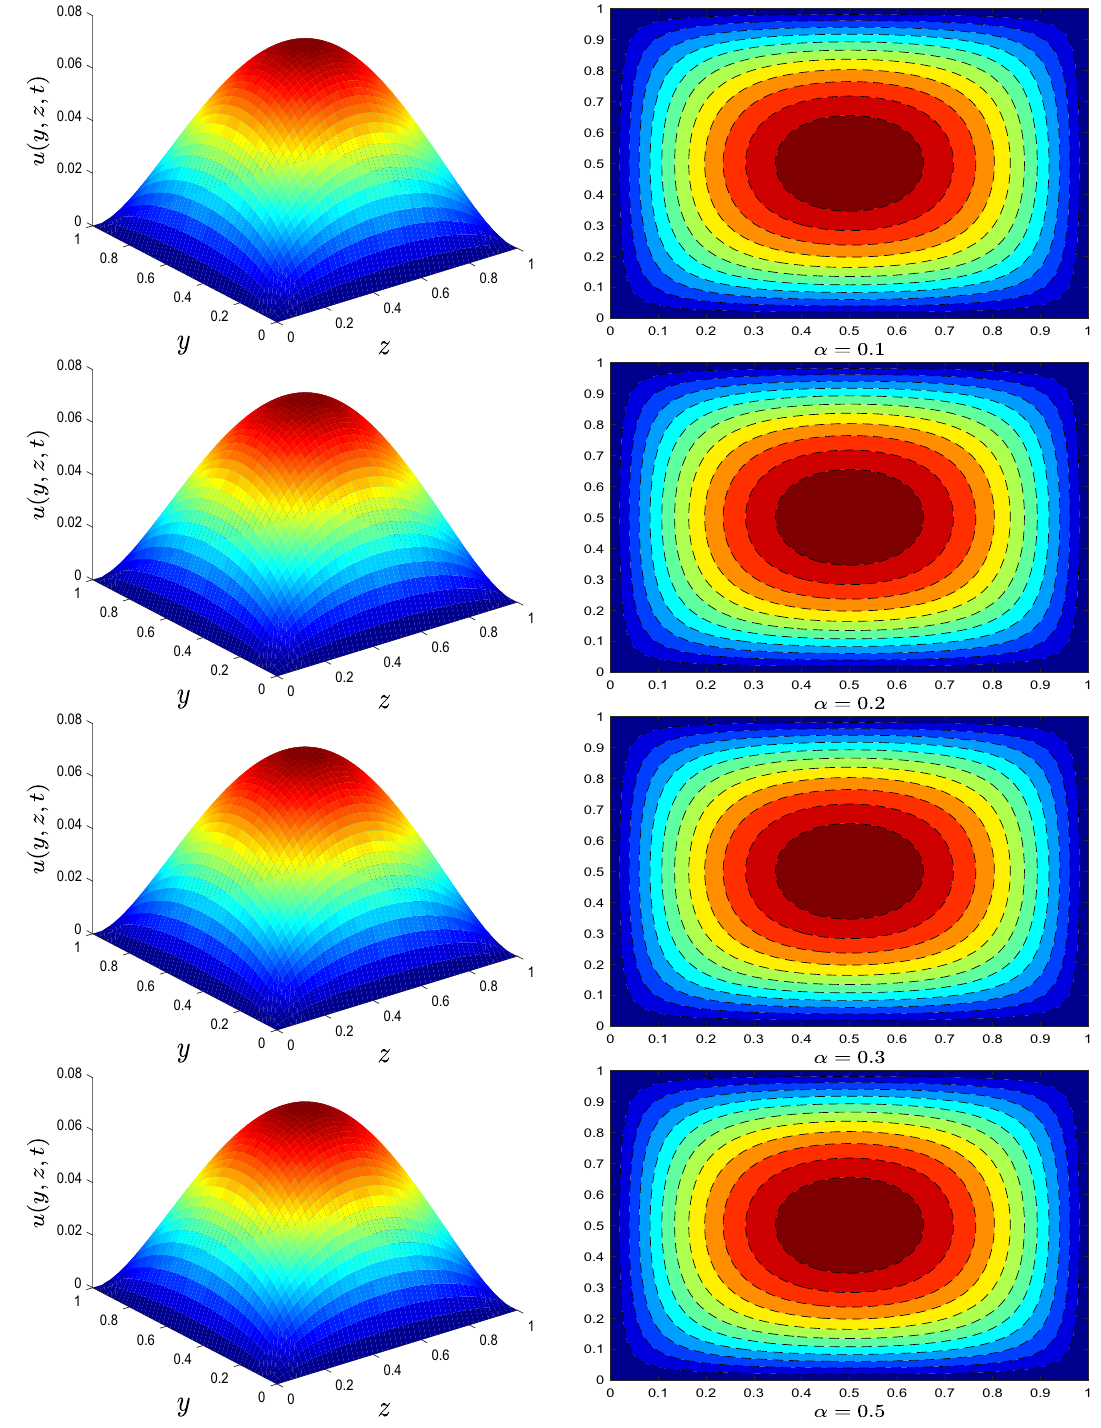
Figure 1. Velocity profile for different values of fractional derivative parameter α